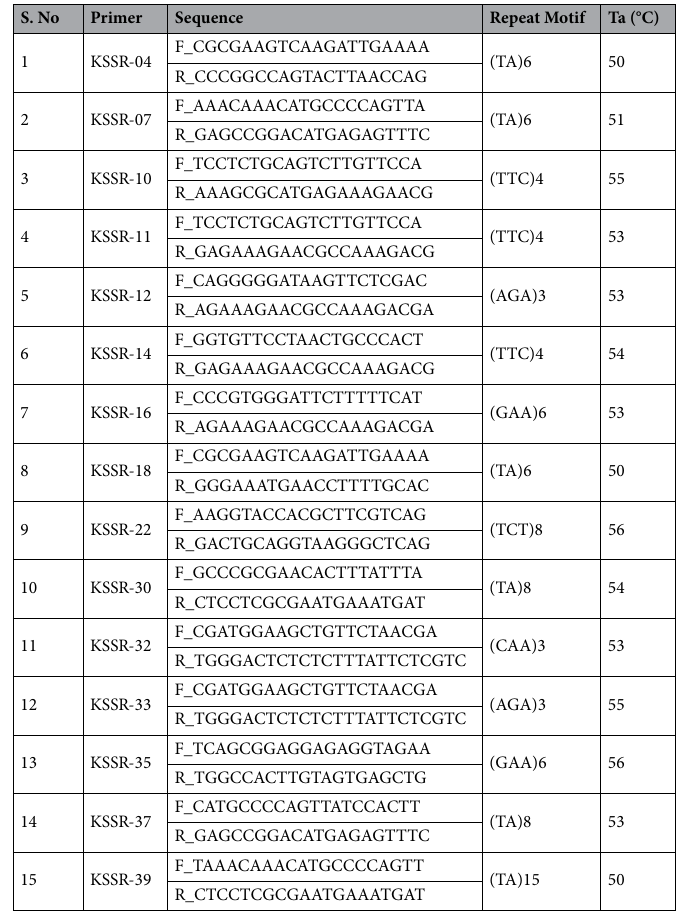
Table 7. Details of 15 polymorphic microsatellites utilised for diversity